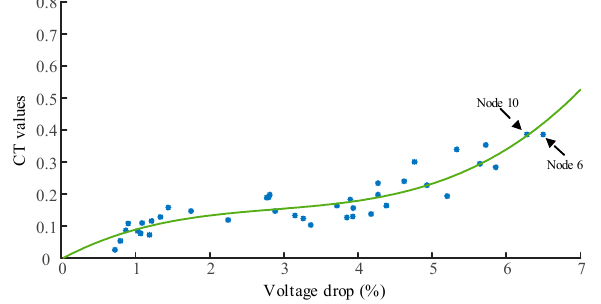
Figure A2. Node CT values and system voltage drop.